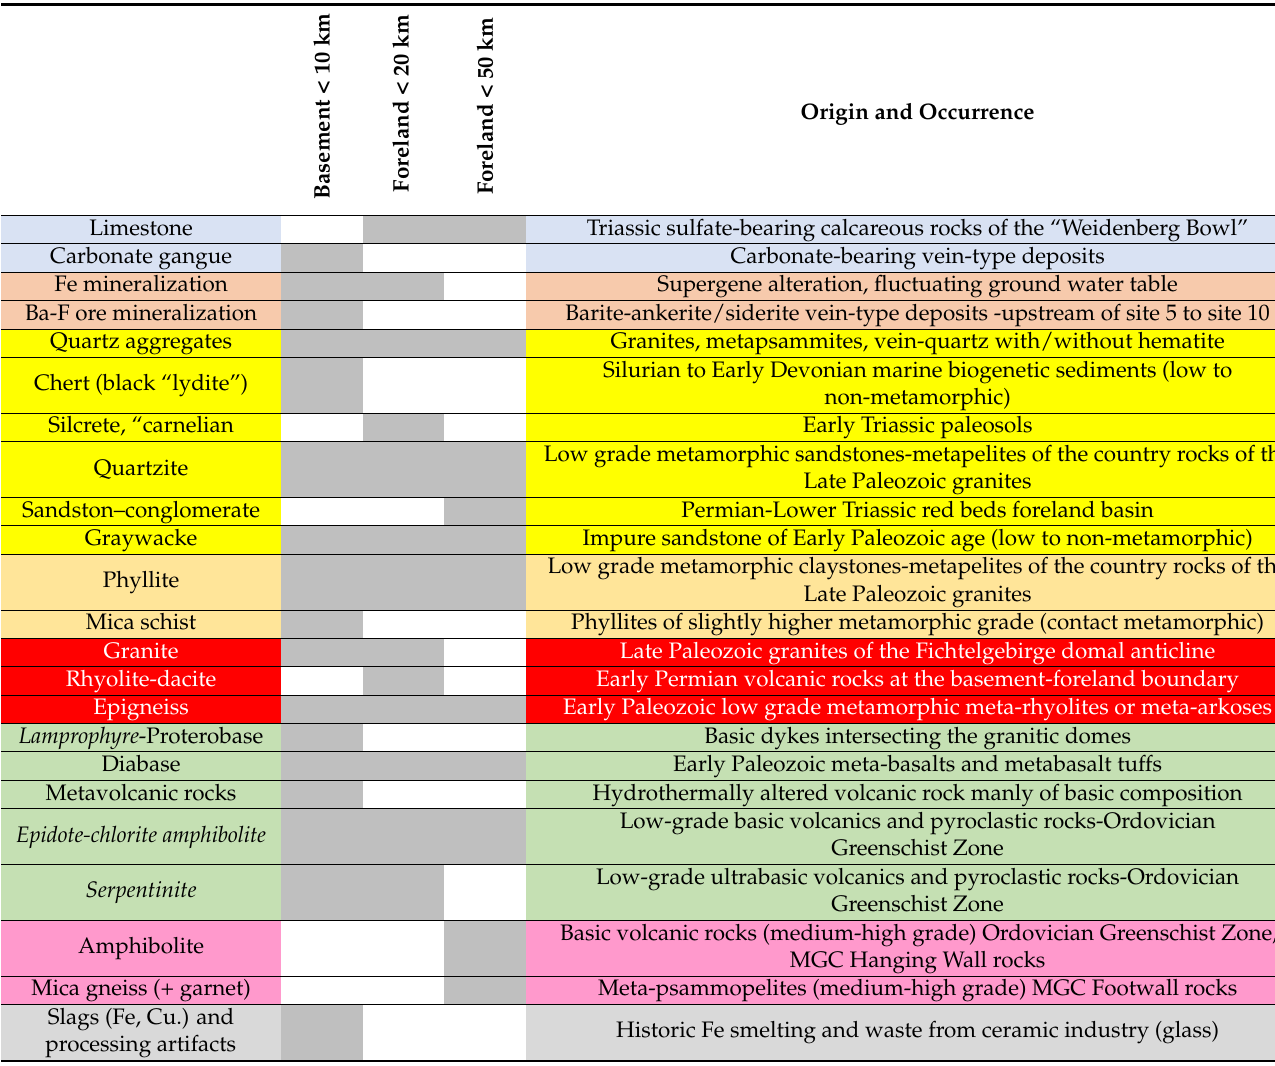
Table 1. Lithology of the detrital clasts of the Steinach-Main drainage system as a function of the distance to source and grain size. Normal font = occurs in the gravel-size class, italics = occurs only in the sand-size class. For the 10 km and 20 km zones, see Figure 3, and for the 50 km zone, Figure 2, as far as the potential source rocks are